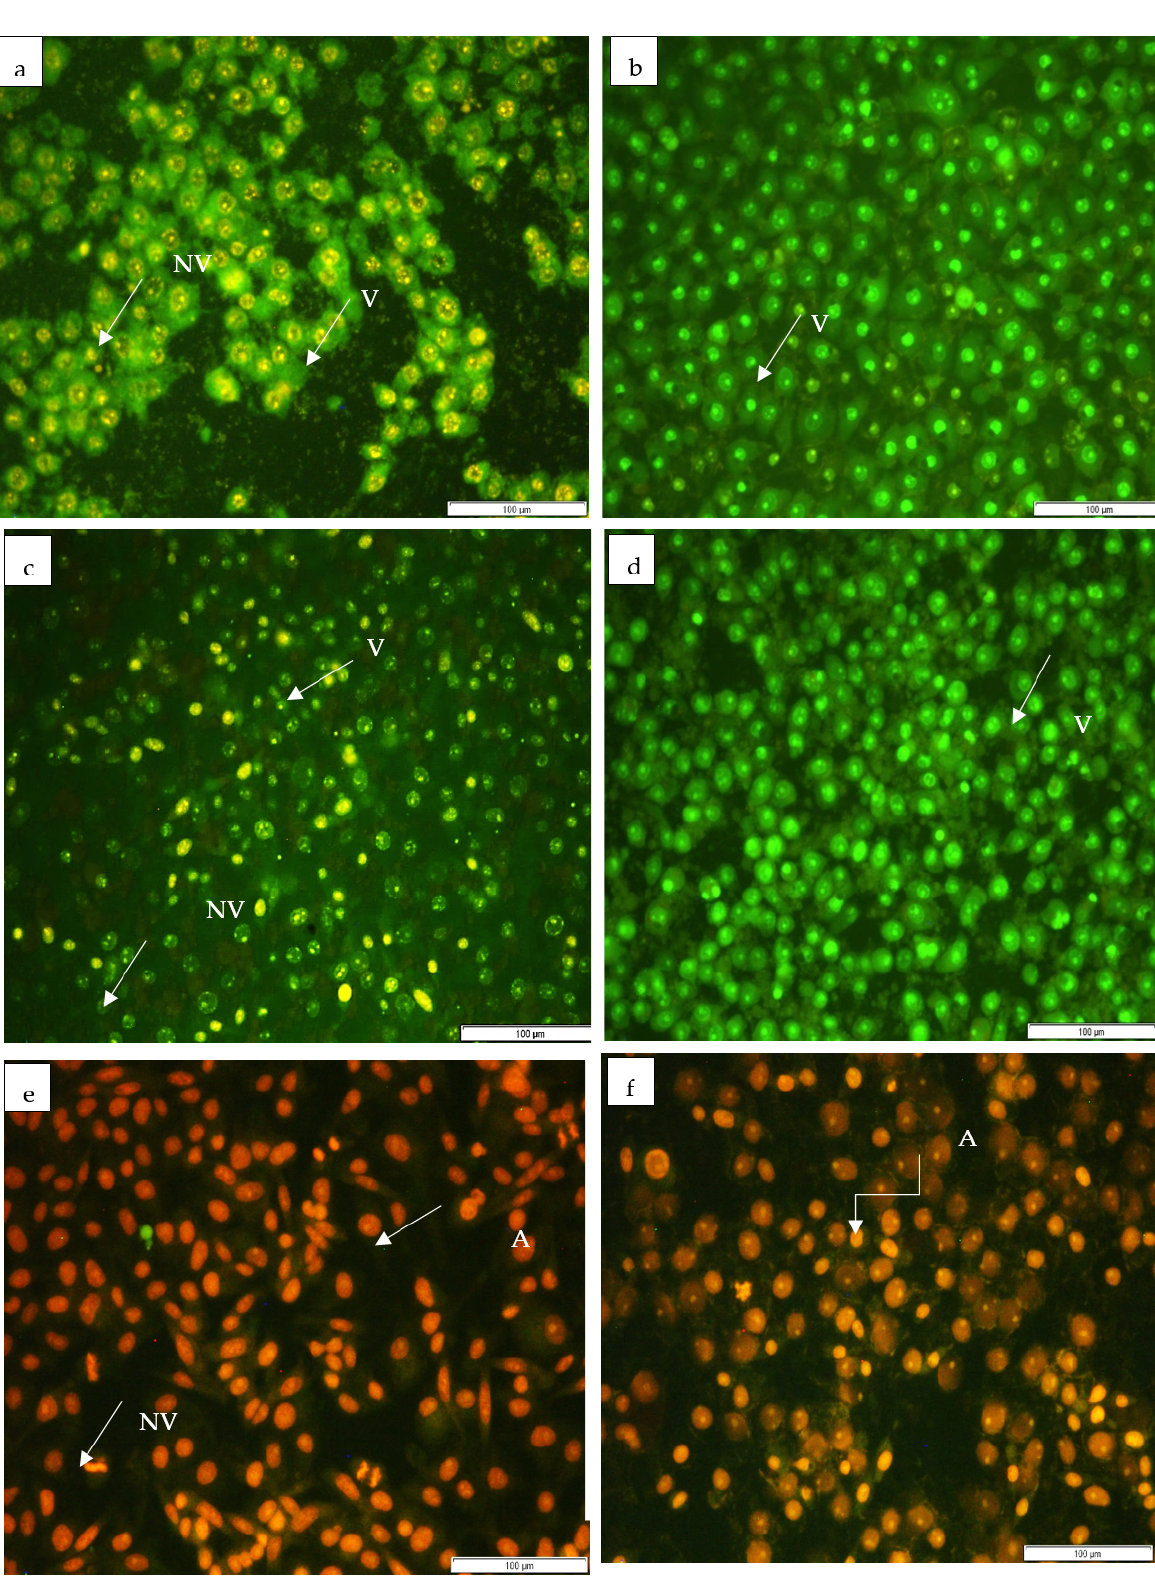
Figure 4. Light micrographs indicating the cell viability of HEK293 cells stained using acridine or- ange and exposed to the following extracts: ( a ) leaf and ( b ) stembark hexane extract, ( c ) leaf and ( d ) stembark chloroform extract, and ( e ) leaf and ( f ) stembark methanolic extracts of C. erythrophyllum (A—apoptotic cell; V—viable cell; NV—non-viable cell).